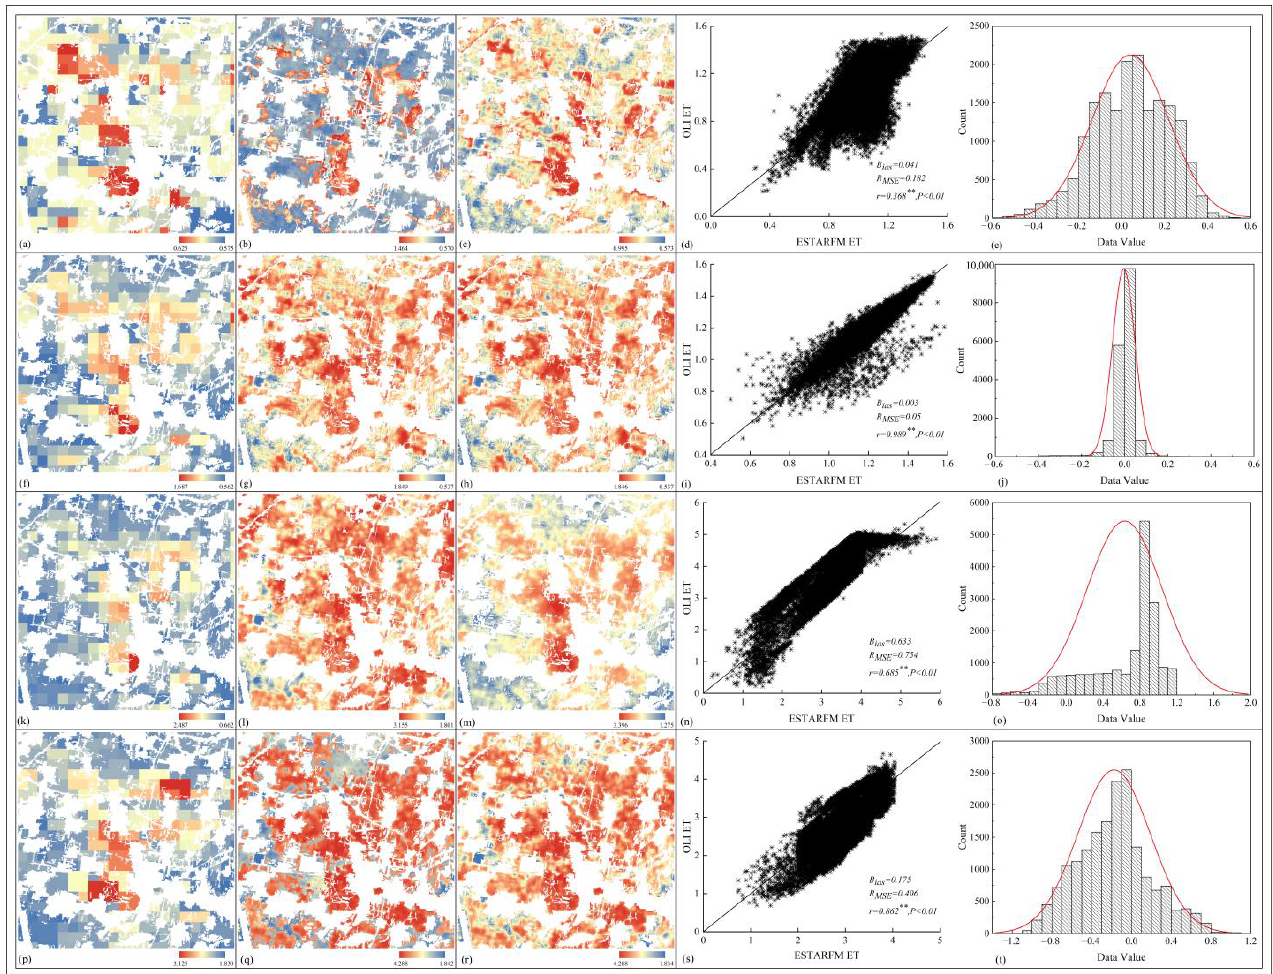
Figure 3. Spatial distribution characteristics of MODIS ET, OLI ET, and ESTARFM ET: ( a , f , k , p ) represent MODIS ET on 15 March, 31 March, 16 April, and 2 May 2019, respectively; ( b , g , l , q ) represent OLI ET on 15 March, 31 March, 16 April, and 2 May 2019, respectively; ( c , h , m , r ) represent ESTARFM ET on 15 March, 31 March, 16 April, and 2 May, respectively; ( d , i , n , s ) represent scatter plots of all ESTARFM ET and OLI ET pixel points for corresponding dates; ( e , j , o , t ) represent error distribution between OLI ET and ESTARFM ET for corresponding dates.